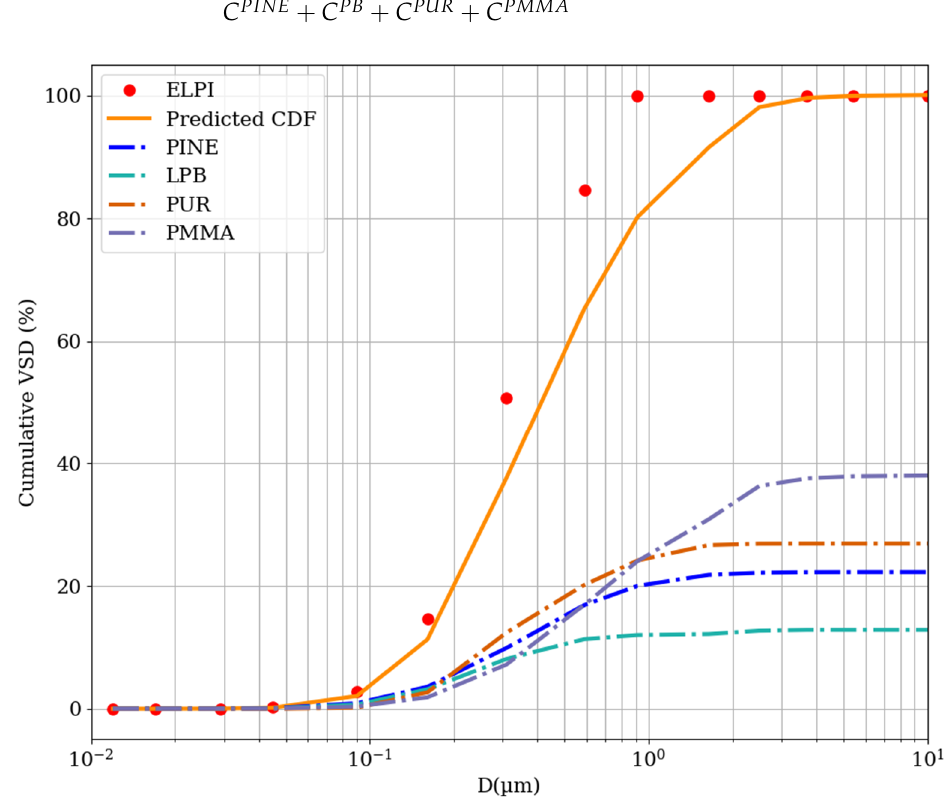
Figure 3. Cumulative volume size distribution of particles emitted during the MIX fire. The red dots represent values measured with the ELPI. The orange line is the predicted CDF line, which is the normalized sum of the four CDFs of the raw materials (dash-dotted lines; blue—pinewood, sea green—particle board, dark orange—PUR foam, and medium purple—PMMA).